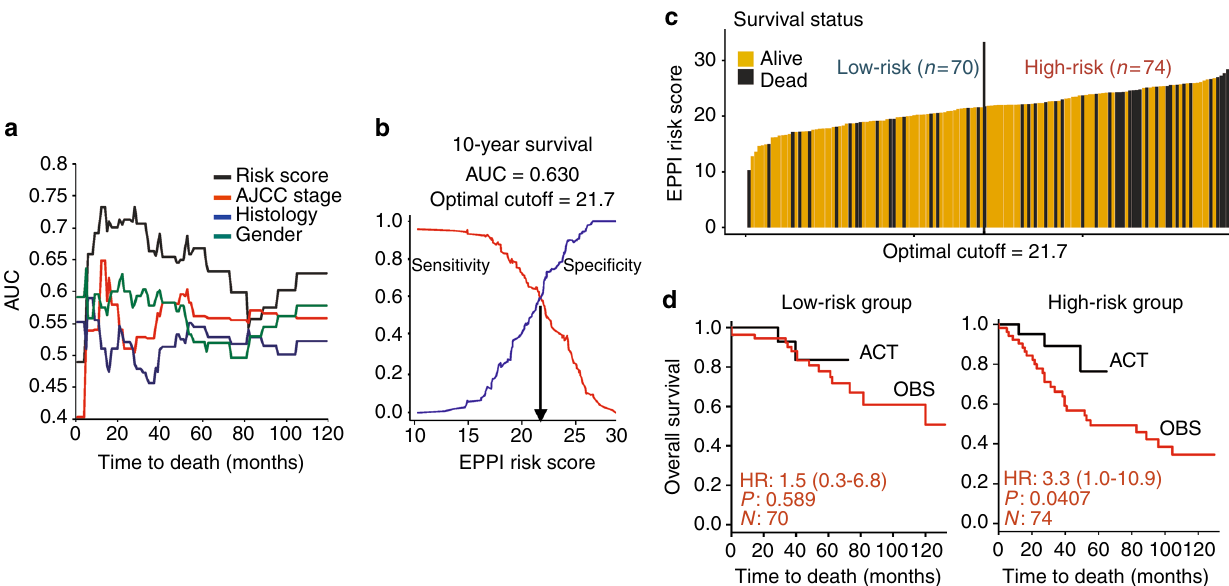
Fig. 6 Predictive value of the EPPI gene signature. a Time-dependent AUC analysis of EPPI risk score and other clinical variables in GSE42127 regardless of adjuvant chemotherapy (ACT) history. b Time-dependent ROC curves at 10 year are shown with best trade-off between sensitivity and speci fi city (optimal cutoff = 21.7). c The EPPI risk score distribution, survival status and patient strati fi cation based on optimal cutoff determined from ROC analysis are shown (high-risk vs. low-risk group). d Hazard ratio (HR), p -value ( P ), and the number of patients successfully classi fi ed ( N ) determined from univariate Cox regression survival analyses are shown. Black and red KM curves represent ACT and OBS (observation group: patients without ACT) group,